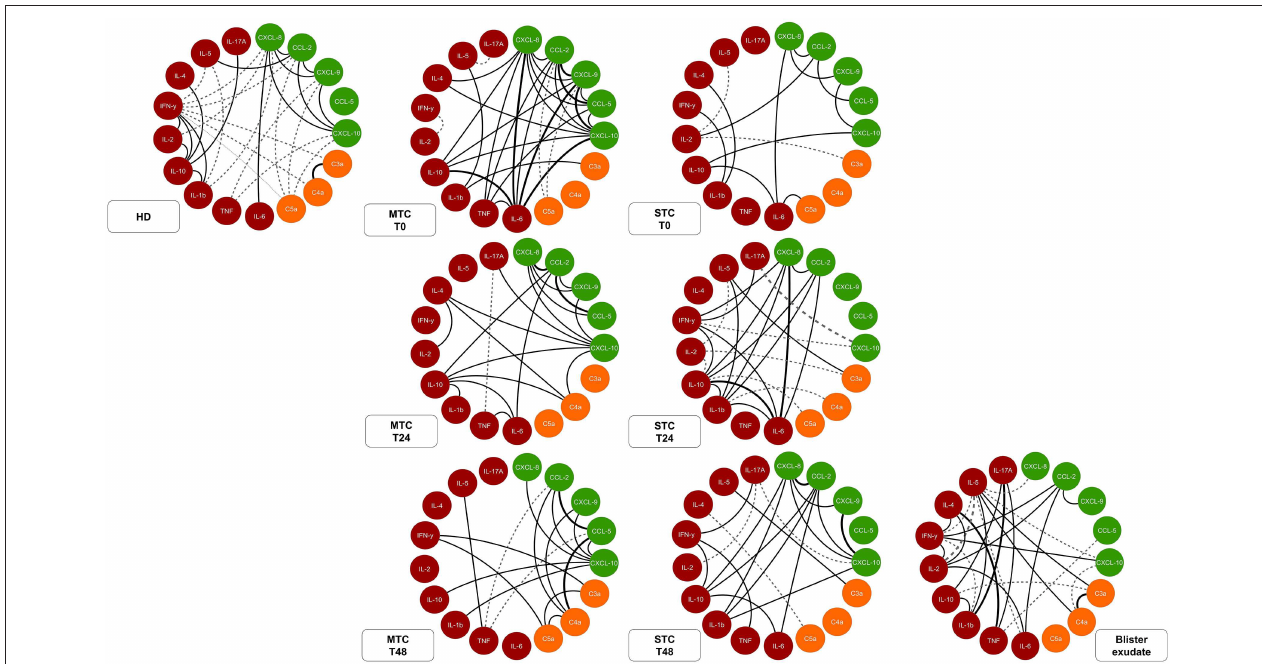
FIGURE 7 | Network of soluble molecules shows interactions occurring throughout the clinical evolution of MTC and STC patients, interaction of the molecules in the control T0 (HD) and interactions at the site (Tissue). Each group of colored nodes is used to identify chemokines (green), anaphylatoxins (orange), and cytokines (red). Dashed lines indicate negative correlation and continuous lines in black, positive correlation, while thickness shows correlation strength. The correlation index (r) was used to categorize the correlation strength as weak ( r ≤ 0.35), moderate ( r ≥ 0.36 to r ≤ 0.67), or strong ( r ≥ 0.68). Immunological Soluble Molecules Level Quantification by CBA and